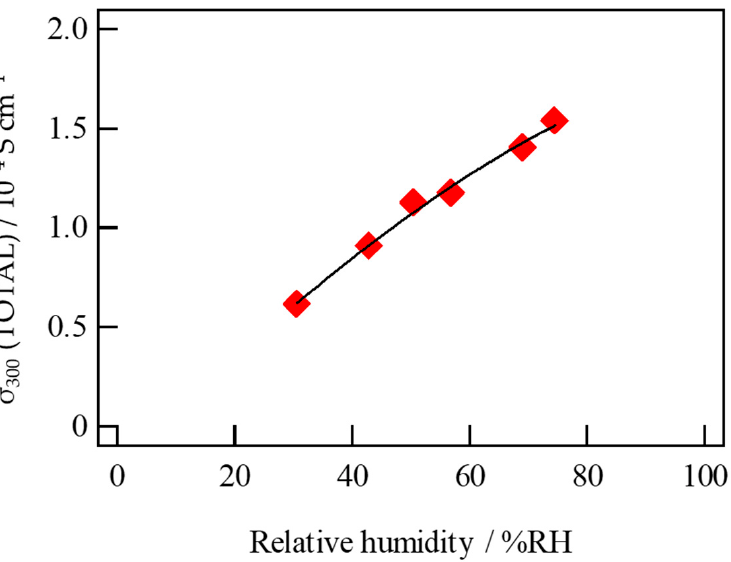
Figure 11. Humidity-sensitive conductivity measured on ion exchanged bulk glass-ceramics at 300 °C.